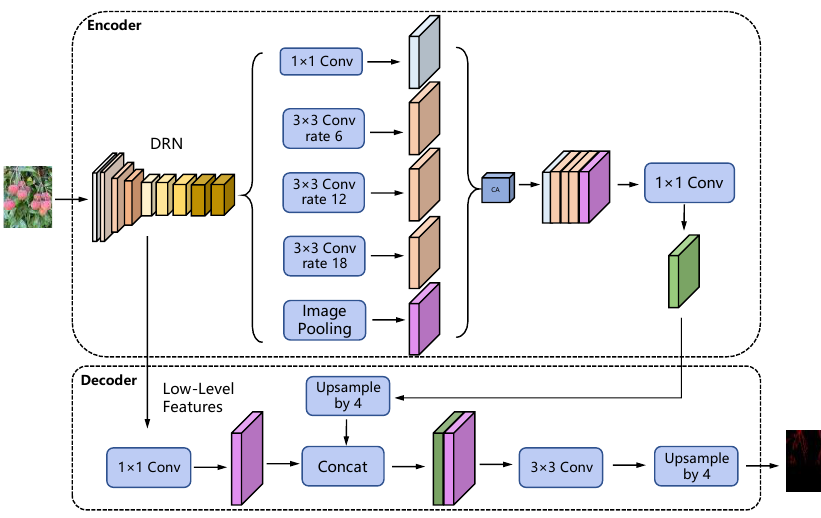
Figure 3. The coordinate attention mechanism.